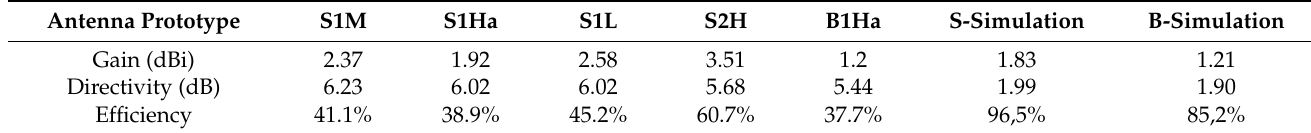
Table 4. Gain, directivity, and efficiency of several